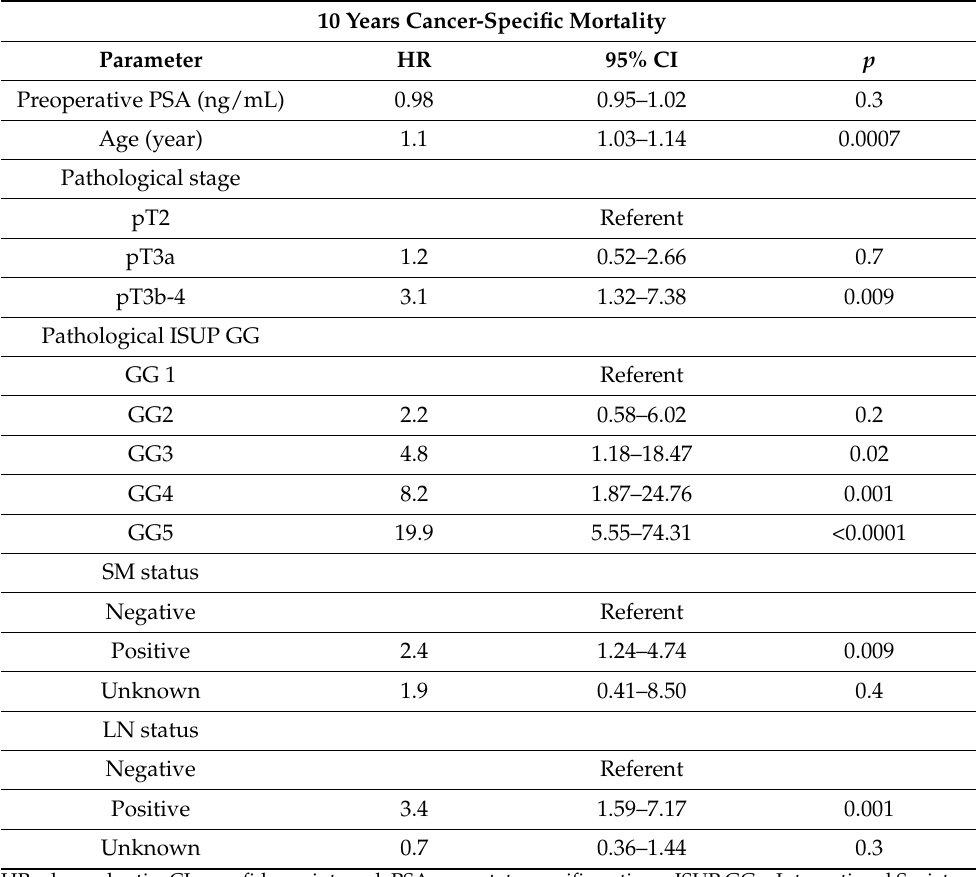
Table 3. Multivariable competing risk analysis of cancer specific